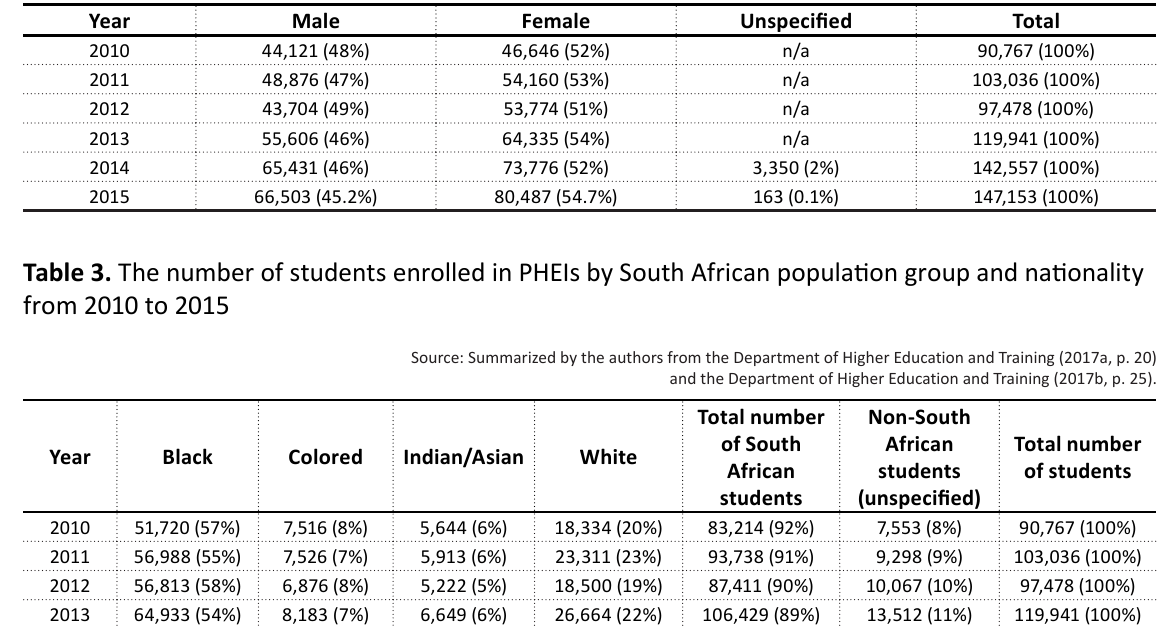
Table 2. Number of students enrolled in PHEIs by gender from 2010 to 2015